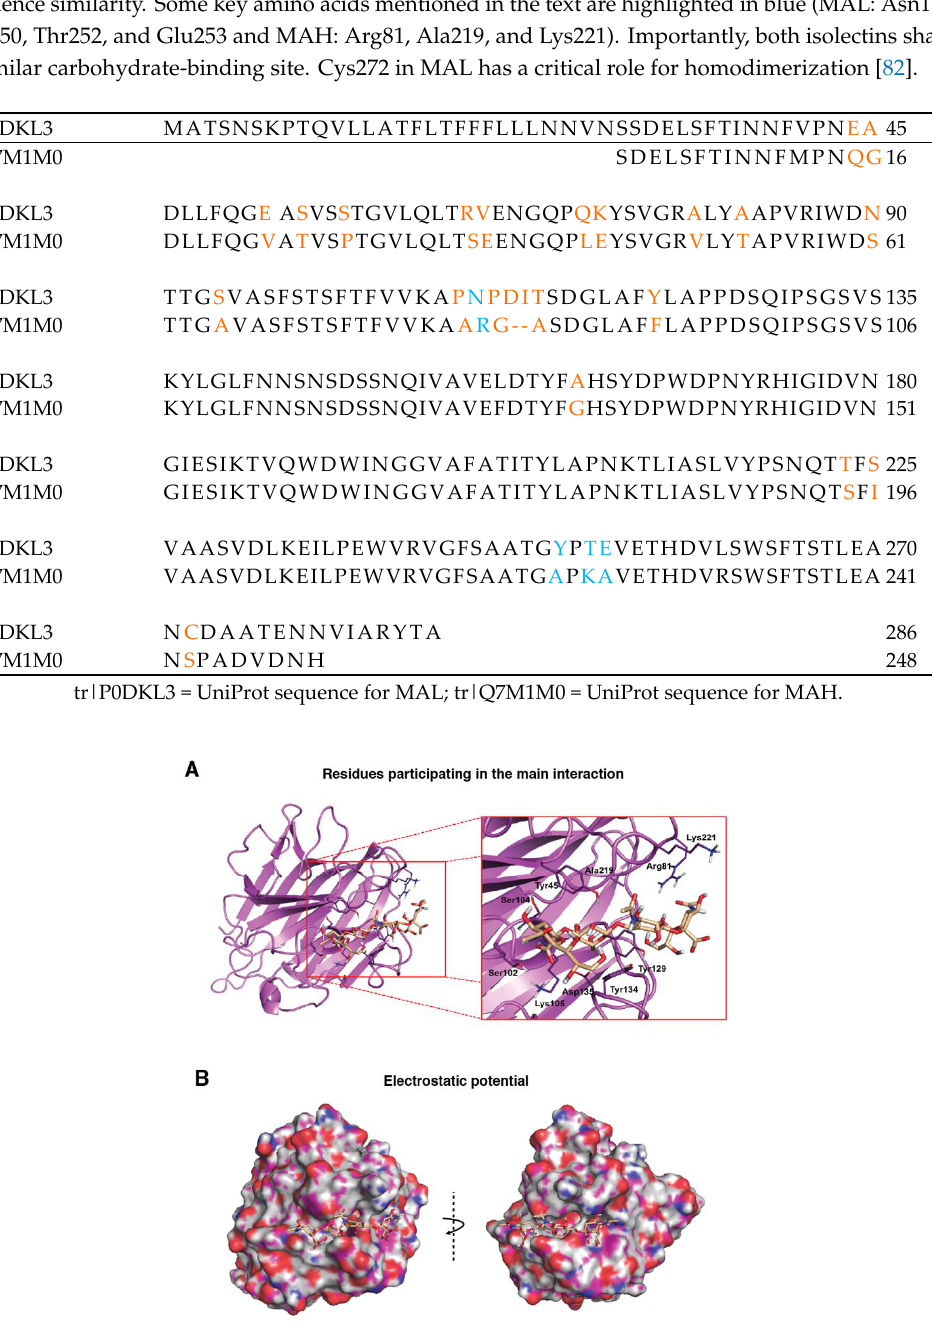
Figure A2. Molecular binding model for the interaction between the PDPN tetrasaccharide 2 and MAH. The MAH homology model (Ref. Q7M1M0, UniProt) was generated with the Phyre2 web portal server [84] sing MAL (Ref. P0DKL3, UniProt) as a template, with a query cover of 95% and a percentage of identity of more than 80% (Table A1). Docked tetrasaccharide 2 (Neu5Acα(2–3)Galβ-(1–3)[Neu5Acα(2–6)]GalNAc, shown in beige) in complex with MAH (magenta). (A) Selected residues participating in the main interactions are displayed in sticks and labels are shown and ( B ) Surface representation of MAH in complex with docked tetrasaccharide 2. The electrostatic potential is coloured on the surface of the protein from red (negative) to blue (positive).